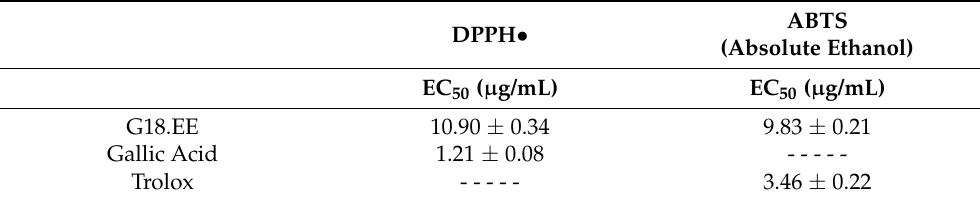
Table 1. DPPH • and ABTS • scavenging activities of G18.EE. Results are expressed in EC 50 ( µ g/mL) as mean ± standard deviation (SD). Gallic acid and Trolox were used as standards for the DPPH and ABTS assays,